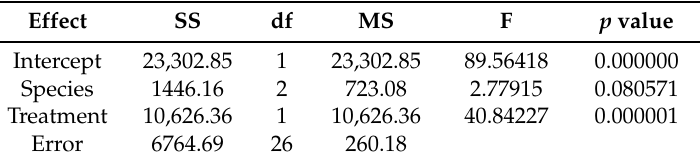
Table 4. Analysis of variance of wood weight